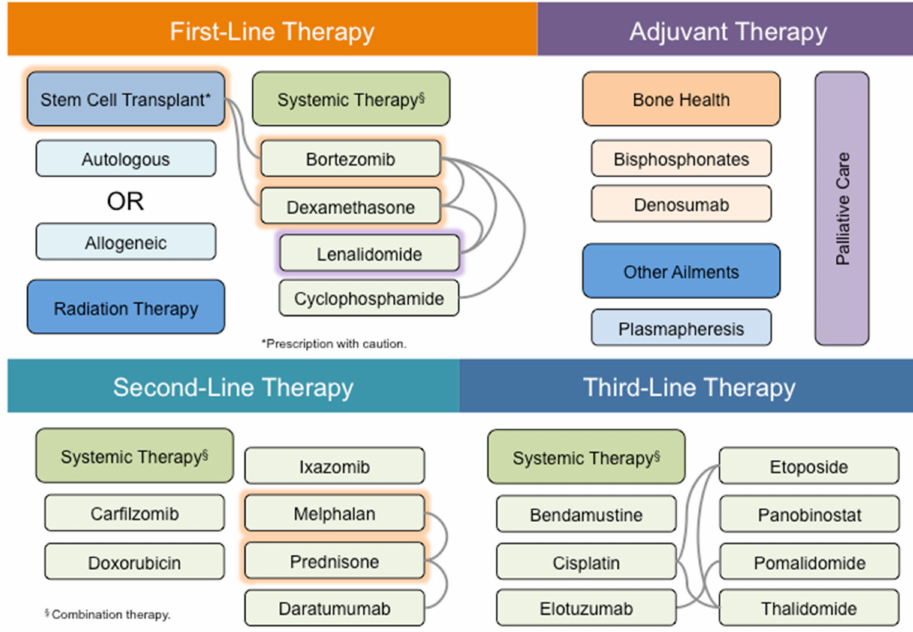
Figure 3. Therapeutic options of MM. Systemic therapy is the most common treatment option for MM patients. Systemic therapy is usually administered in a combined manner, with synthetic drugs and antibodies (green box), or in conjunction with stem cell transplant (cyan box). For example, bortezomib and dexamethasone constitute the adjuvant therapy for stem cell transplant patients in first-line therapy (shadowed in orange and connected by gray lines). On the other hand, melphalan and prednisone are recommended for non-transplant patients in first-line therapy (shadowed in orange and connected by gray lines). Alternatively, lenalidomide may be recommended with bortezomib and dexamethasone in non-transplant patients in first-line therapy (connected by gray lines) or administered alone during palliative care (shadowed in purple). Therapeutic options are color-coded in boxes according to their application and placed or shadowed under the categories of first-line (orange), second-line (cyan) and third-line (blue) therapy, or palliative care (purple), according to the frequency of recommendation for clinical use under the National Comprehensive Cancer Network (NCCN) guidelines. Combination therapies on the same line of therapy are connected by gray lines, whereas those spanning across di ff erent lines of therapy are not